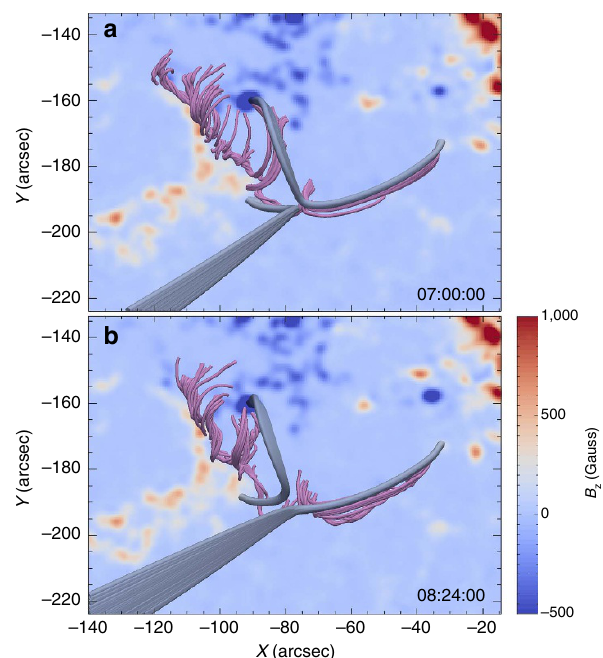
Figure 5 | 3D configuration of the reconnection region from NLFFF extrapolation. ( a , b ) 3D NLFFF configuration before (07:00 UT on 3 October 2014) and after (08:24 UTon 3 October 2014) the reconnection. The background images indicate the radial component of the vector magnetic field in the photosphere. The grey lines represent the magnetic loops involved in the reconnection. The pink lines show the magnetic structures of the